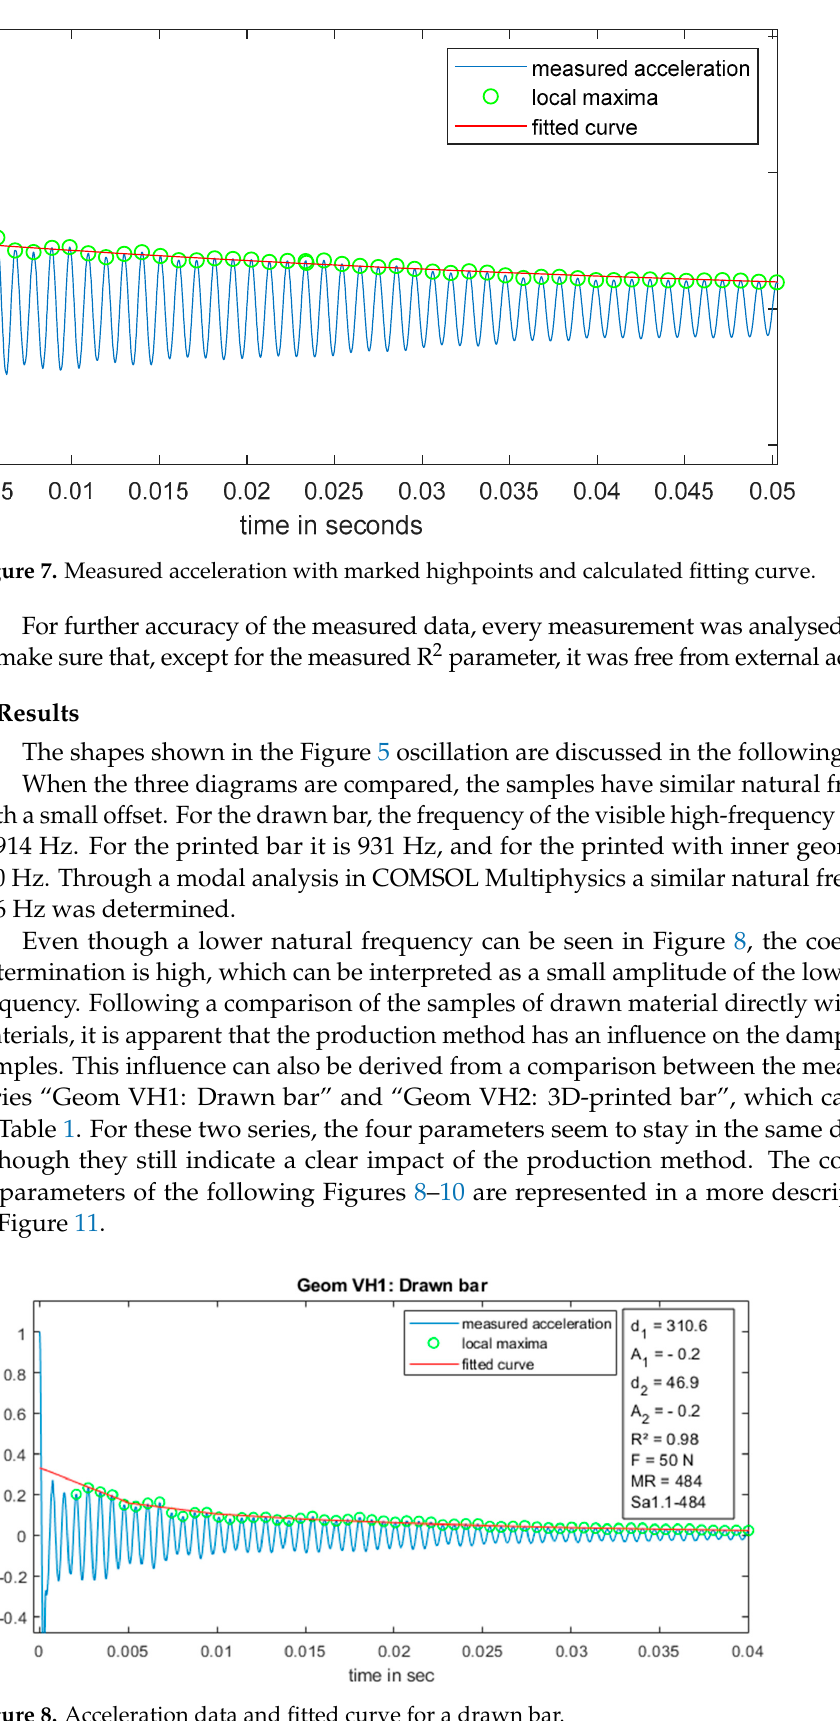
Figure 9. Acceleration data and fitted curve for a printed bar with a rectangular inner shape (force- orthogonal).